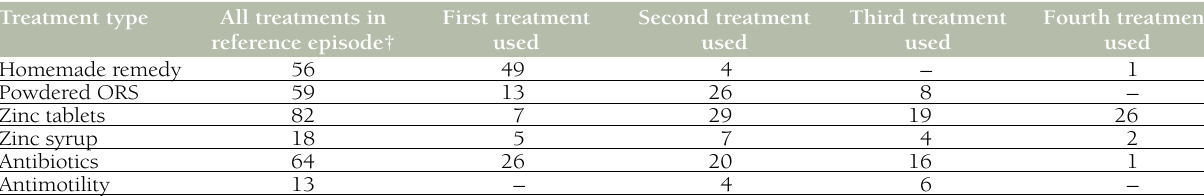
Table 3. Number and sequence of treatments used in the reference episode of diarrhea (n = 100 respondents)* Treatment